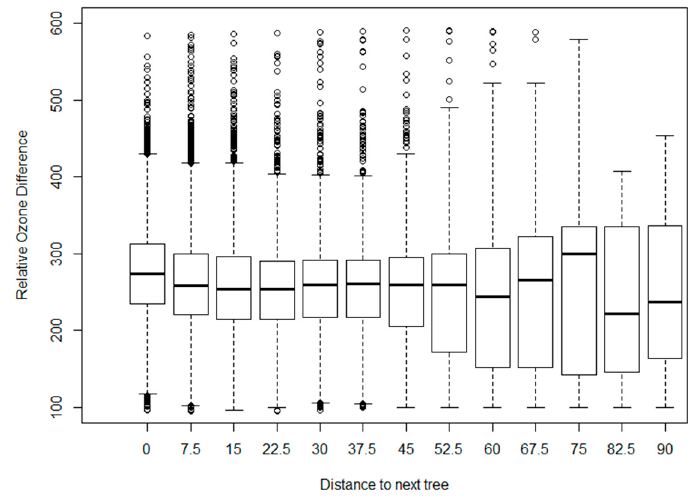
Figure 11. Relation between distance to emitter and relative change in ozone concentration with respect to the whole model domain at 4 pm.